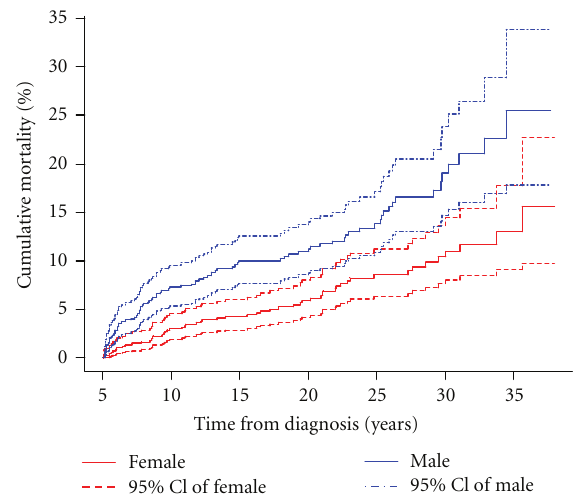
Figure 2: Cumulative mortality by